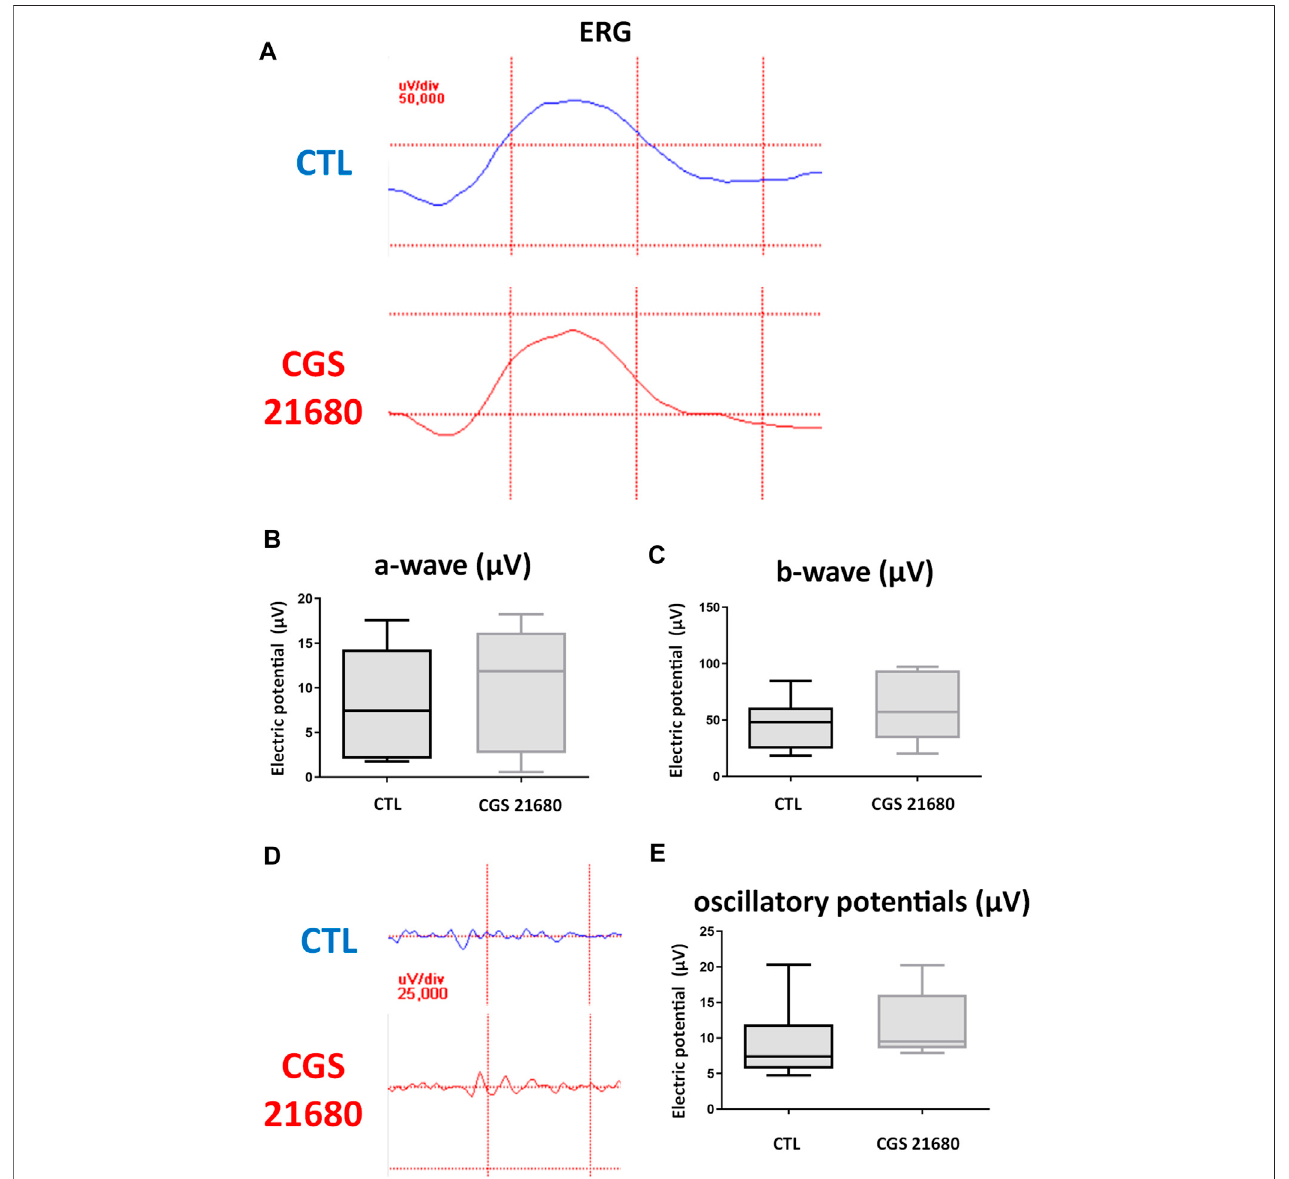
FIGURE 3 | ERG recordings of control eyes (CTL) and CGS21680-treated eyes. (A) ERG recording a CTL eye (above) and a CGS21680-treated eye (below) 1 weekafterCI. (B) Quanti fi cationofa-wave. (C) Quanti fi cationofb-wave. (D) Responseofoscillatorypotentials1 weekafterexposuretoCIofaCTLeye(above)andan eye treated with CGS21680 (below). (E) Quanti fi cations of OP. Boxes represent 25 and 75 percentiles, whiskers represent minimum and maximum values, and transverse lines represent medians. No statistical differences were found between groups.